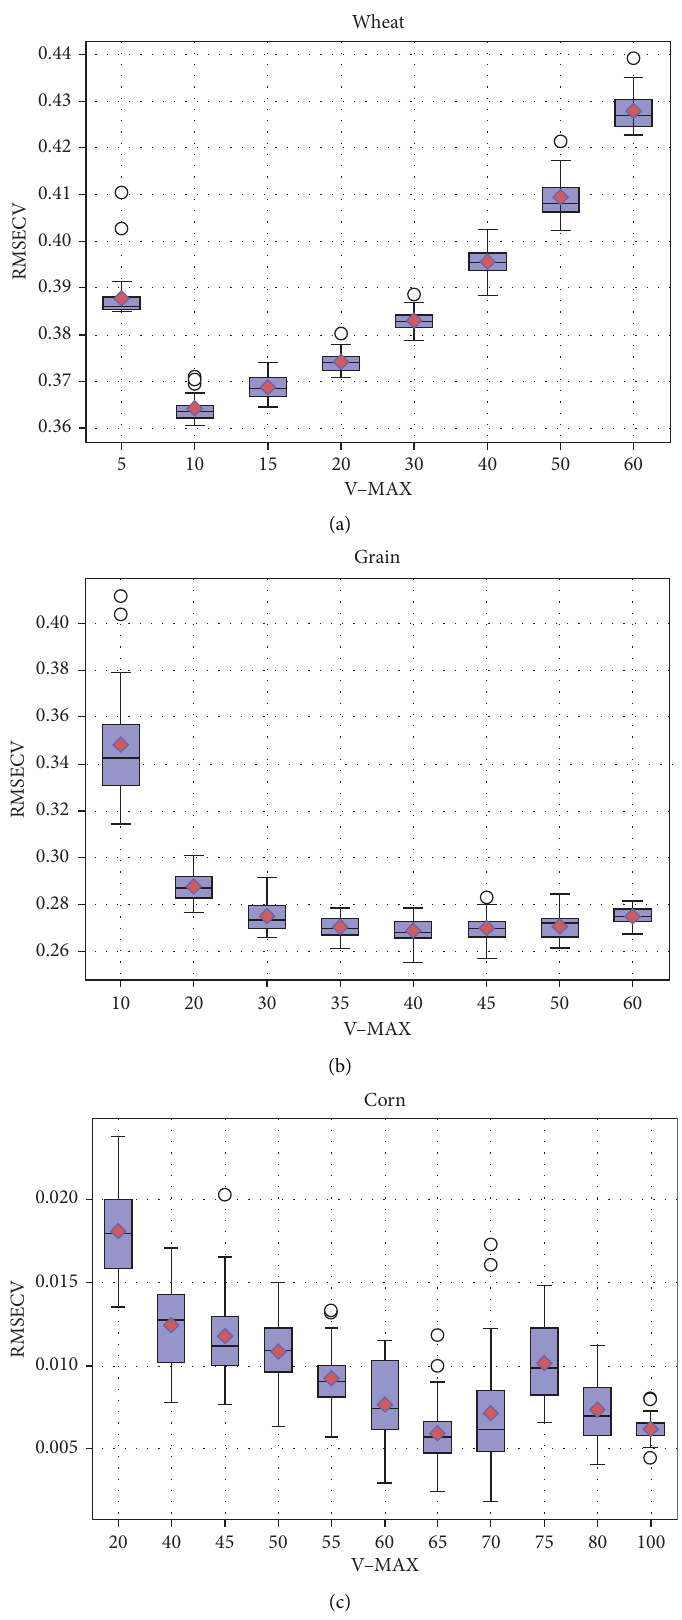
Figure 2: Boxplots of RMSECV under 30 diferent V-MAX values for MLR-ACO testing on three datasets: (a) wheat protein dataset, (b) grain casein dataset, and (c) corn protein